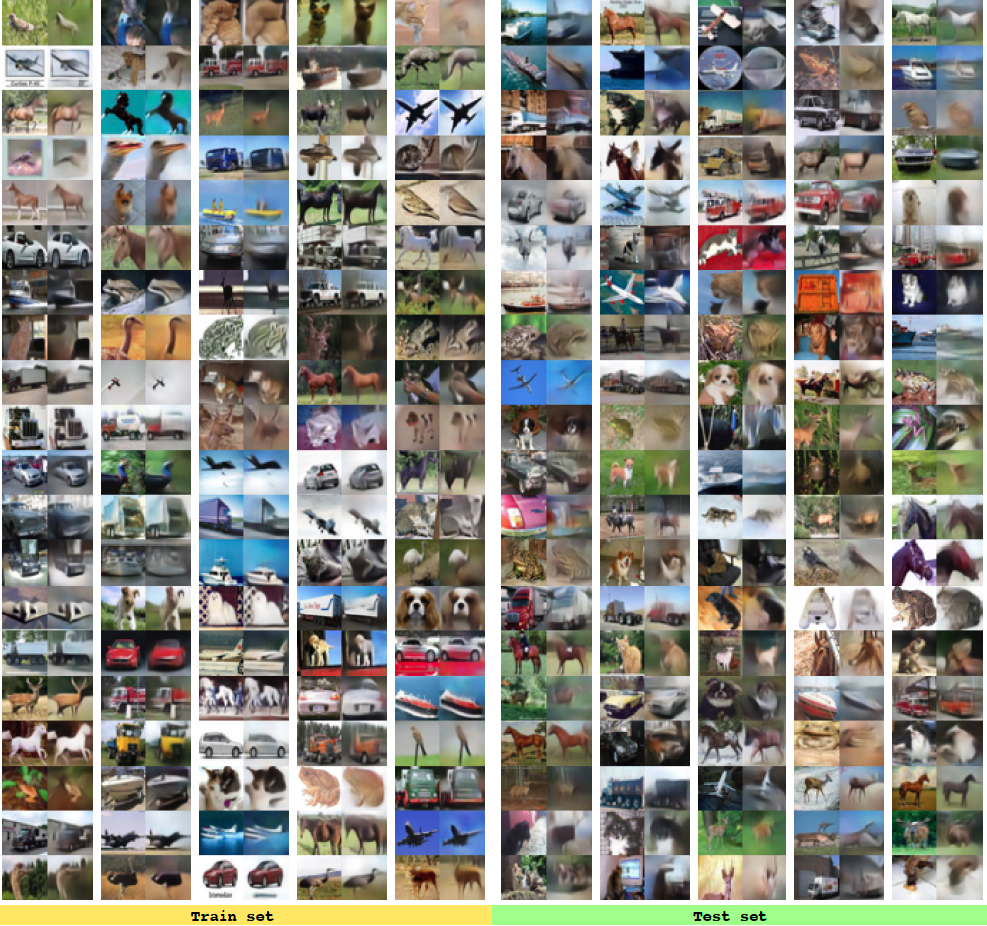
Figure 10. Several pairs of random images with their reconstructed output of the